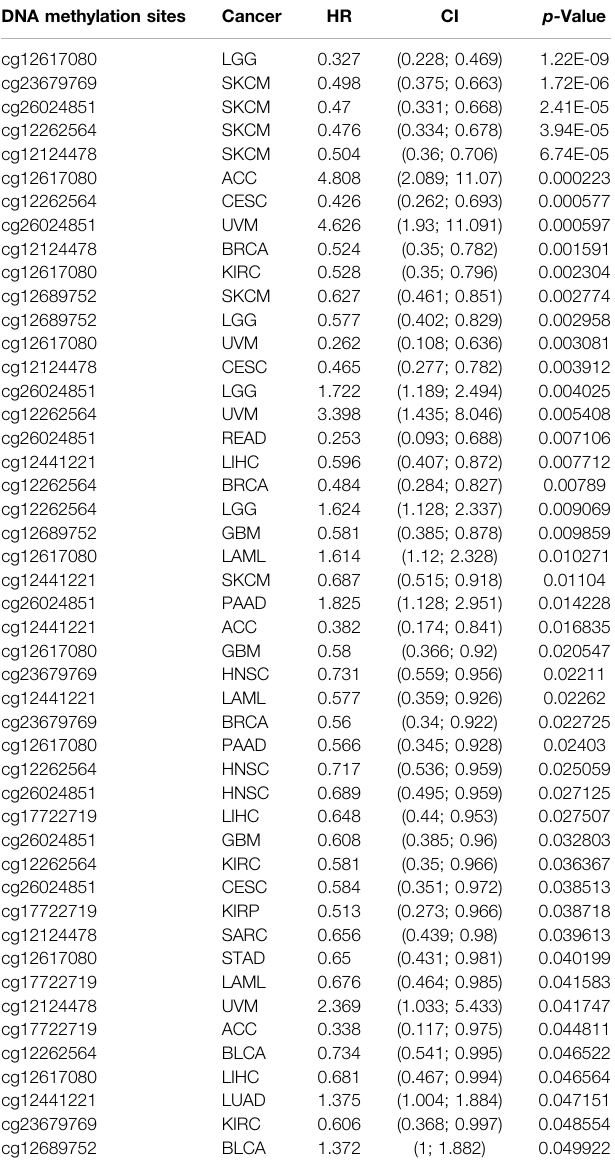
TABLE 2 | Analysis of the correlation between the DNA methylation of IQGAP3 and prognosis of cancer patients. DNA methylation